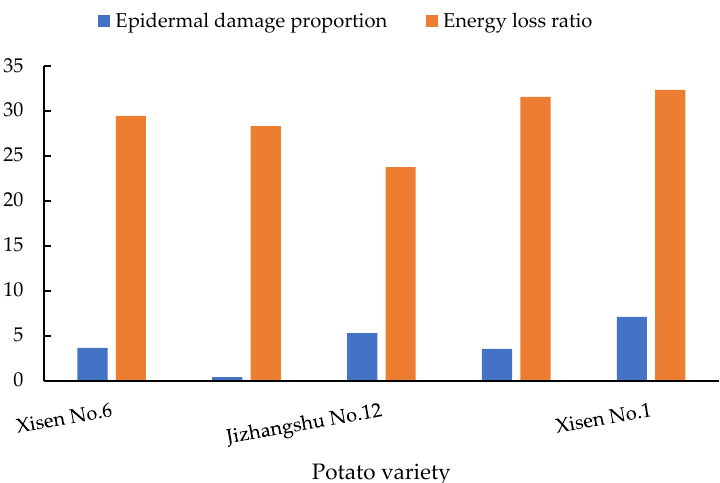
Figure 7. Relationship between potato varieties and evaluation indexes. Note: The standard deviation range for the proportion of epidermal damage is 0–1, and the standard deviation range for the energy loss ratio is 1–6.